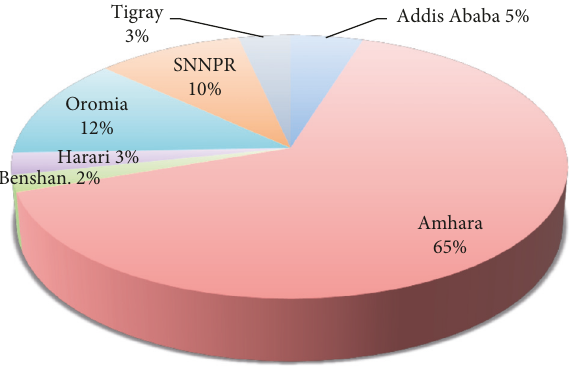
Figure 2: Regional distribution of respondents. Table 3: Summary statistics of ways of getting the first-time job. How did you find your first